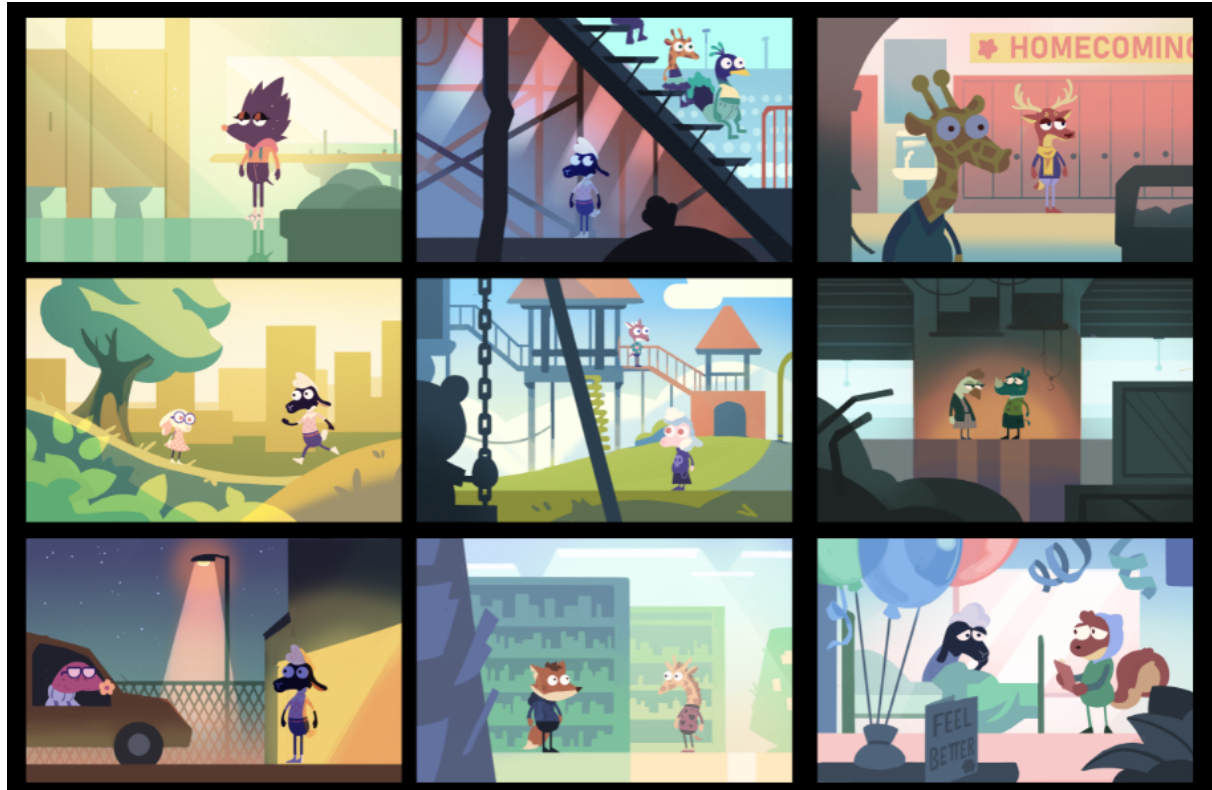
Figure 2. Anthropomorphized characters in the MEDSMAR x T